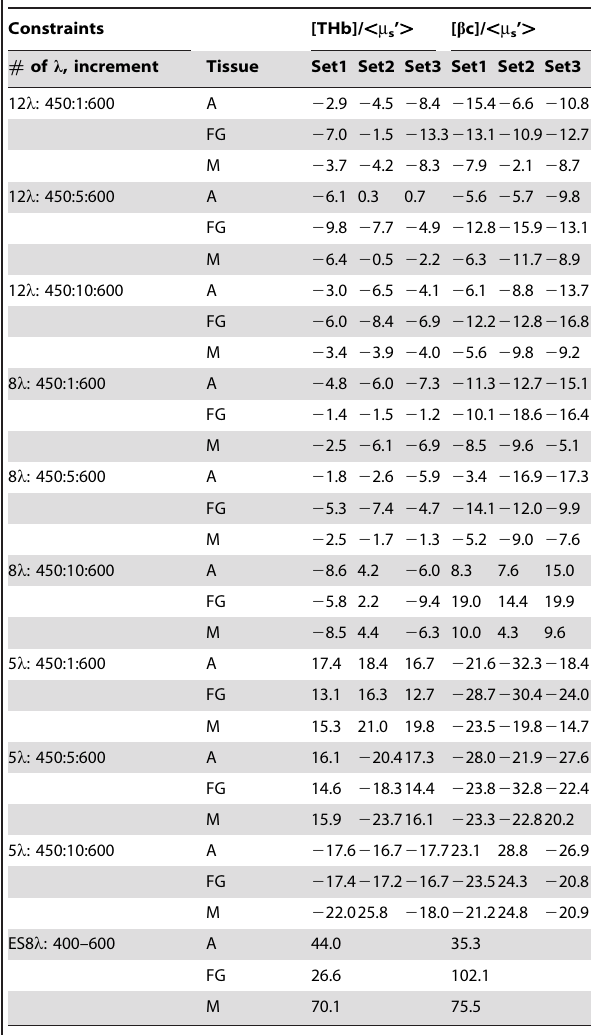
Positive values indicate an over-estimation of the extracted parameters while negative values indicate an under-estimation of the parameters. [THb]: total hemoglobin; [ b c]: b -carotene; , m s ’ . : reduced scattering coefficient; A: adipose tissue; FG: fibroglandular; M: malignant tissue; ES8 l : semi-evenly spaced 8 wavelengths (400, 420, 440, 470, 500, 530, 570, 600 nm).